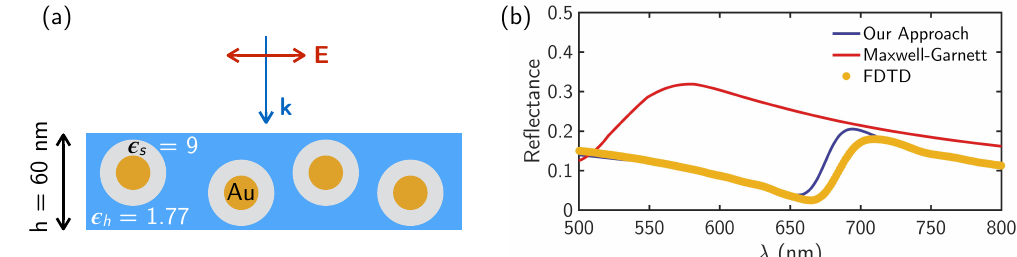
Figure 8. ( a ) scheme of the system under study: an slab (i.e., host medium) with constant real dielectric function (cid:101) h = 1.77 with core-shell inclusions ( R c = 10 nm and R s = 20 nm ). The core is made of Au and the shell has a constant real dielectric function of (cid:101) s = 9. The system is illuminated under normal incidence ( k ) with a linear polarized wave ( E ); ( b ) reflectance calculations on the system in sketched in ( a ). Yellow dots represent the numerical solution of the reflectance given by FDTD simulations. The reflectance calculated using the Transfer Matrix Method [35] in a system like that of Figure 9 is plotted: using in step ( i ) the proposed approach (blue line) and Maxwell Garnett (red line), and in step ( ii ) Maxwell